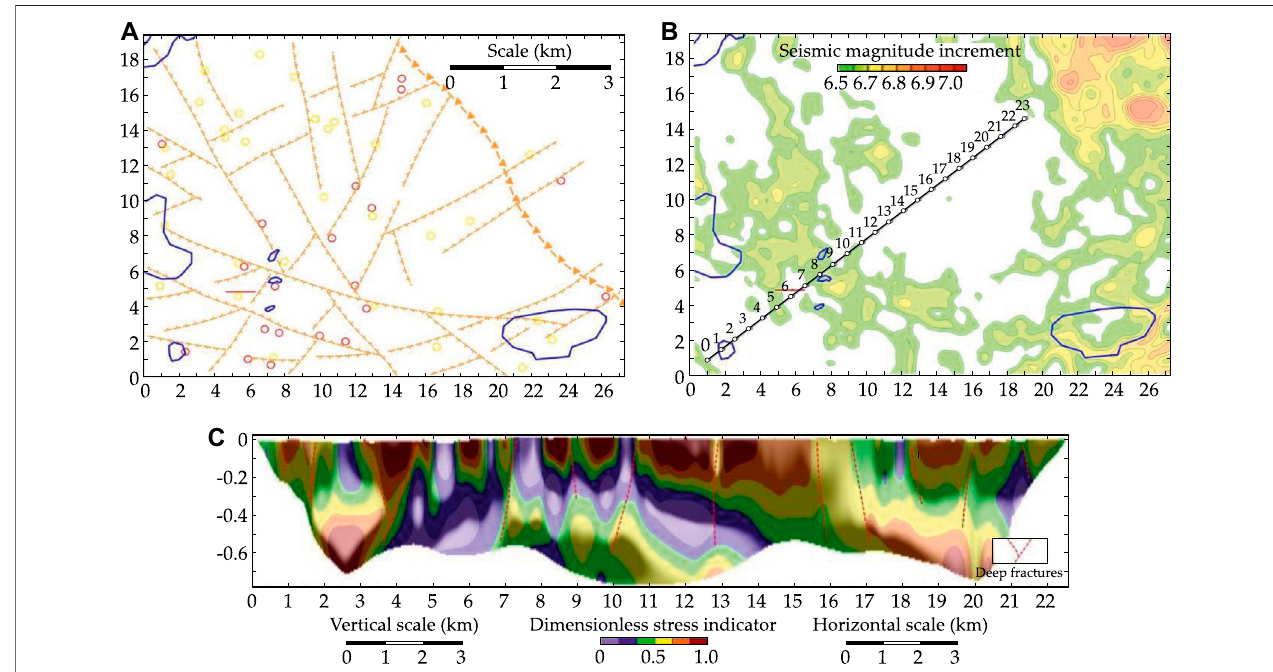
FIGURE 3 | Reconstruction and ranging of geodynamic zones: (A) the zone imaging: 1 — strip-shaped GDH; 2 — zone of hypothetical looming; 3 — geostructural anomalies; (B) the seismic pro fi le; (EMS intensities) (C) a cross-sectional map representing log of the normalised modulus of the gradient of the height of the Earth ’ s surface. Blue contours represent the regions of the registered seismic damage, horizontal red segment shows the horizontal shaft in the hydraulic fracturing area.